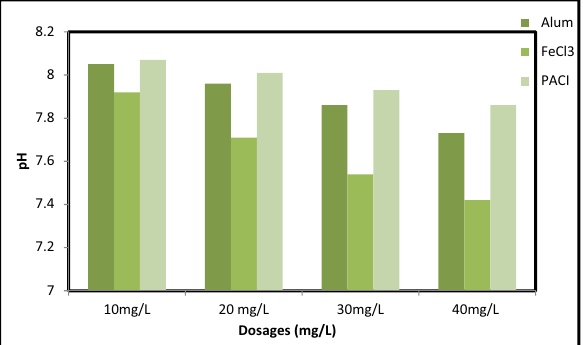
Figure 5: The relation between pH and dose of coagulants for sam - ples at 180 cm